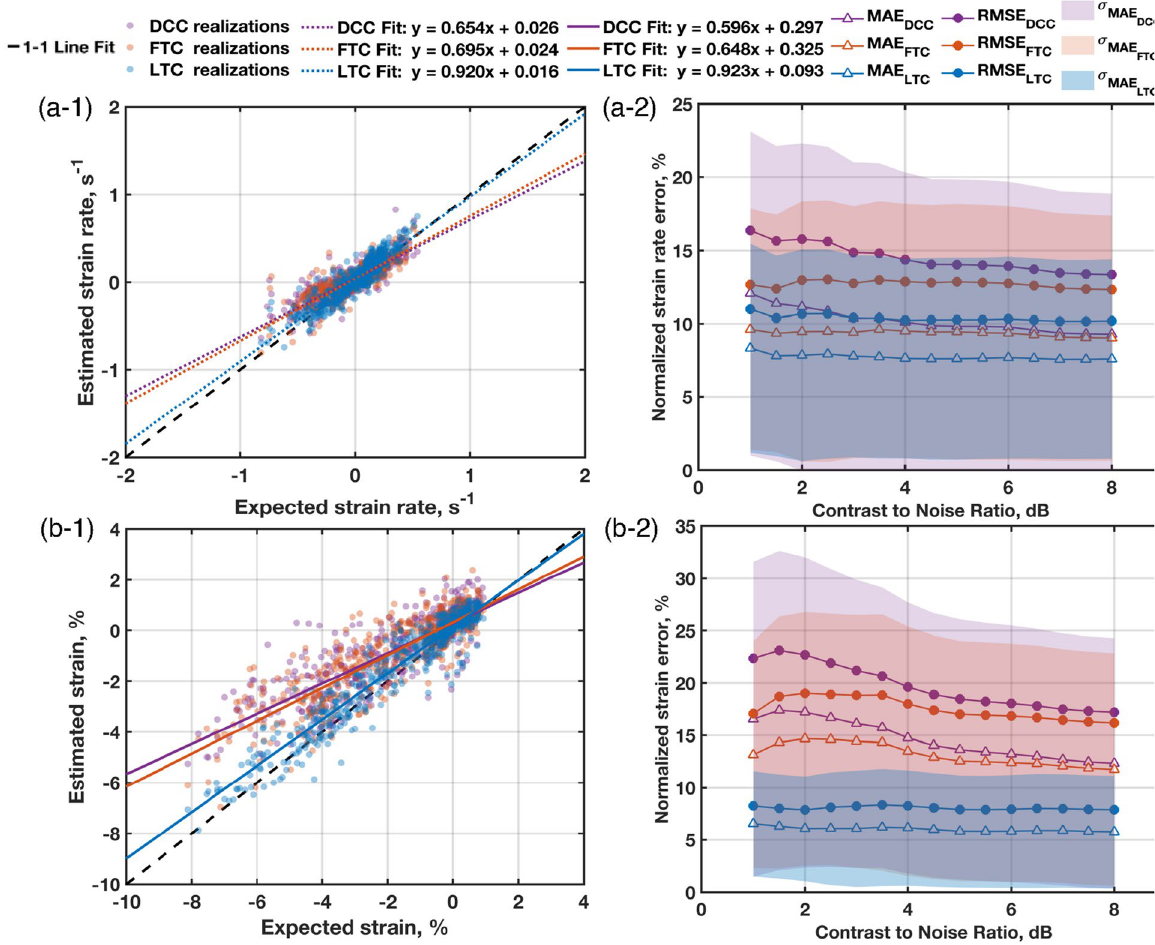
Figure 2. (Left) Direct comparison of measurements to ground truth values and (right) normalized mean absolute error (MAE) and root mean square error (RMSE) as a function of contrast-to-noise ratio (CNR) for ( a ) GLSr and ( b ) GLS quantities. Measurements were performed using the Direct Cross-Correlation method (DCC), Fourier Transform Correlation (FTC), and Fourier-based Logarithm Transform Correlation (LTC). Standard deviation of the absolute error measurements are provided as the shaded regions around the MAE